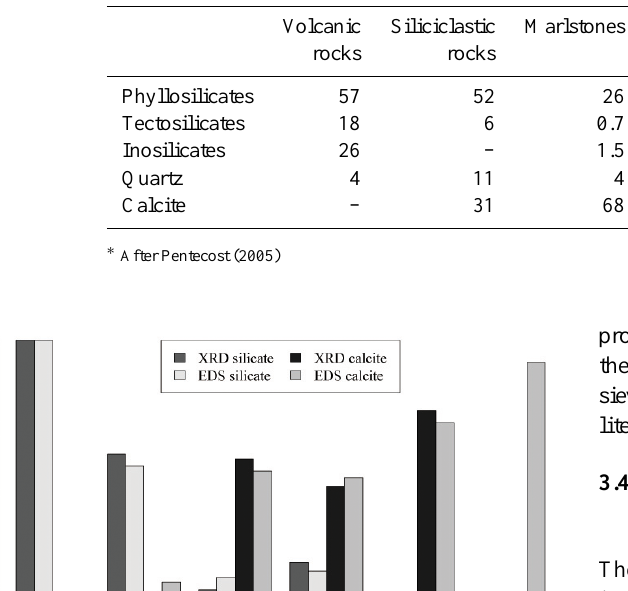
Table 2. Average mineralogical composition (wt%) of dust samples by XRD analysis.